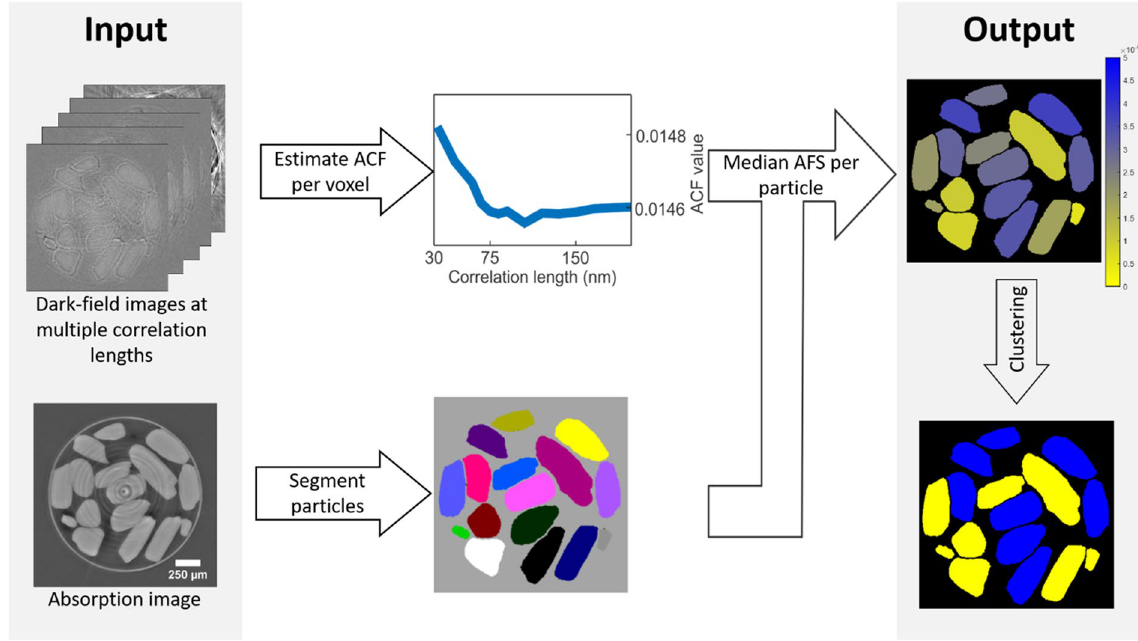
Figure 3. Proposed image analysis algorithm workflow. From the dark-field tomograms at multiple correlation lengths, the autocorrelation function (ACF) is estimated per voxel. Per particle, the median autocorrelation function slope (AFS) is calculated. This AFS is a proxy for the unresolved nominal pore size in the particle. Ultimately, the particles were clustered in two groups representing the particles with nominal pore sizes of 50 and 150 nm, using a k-means clustering algorithm.